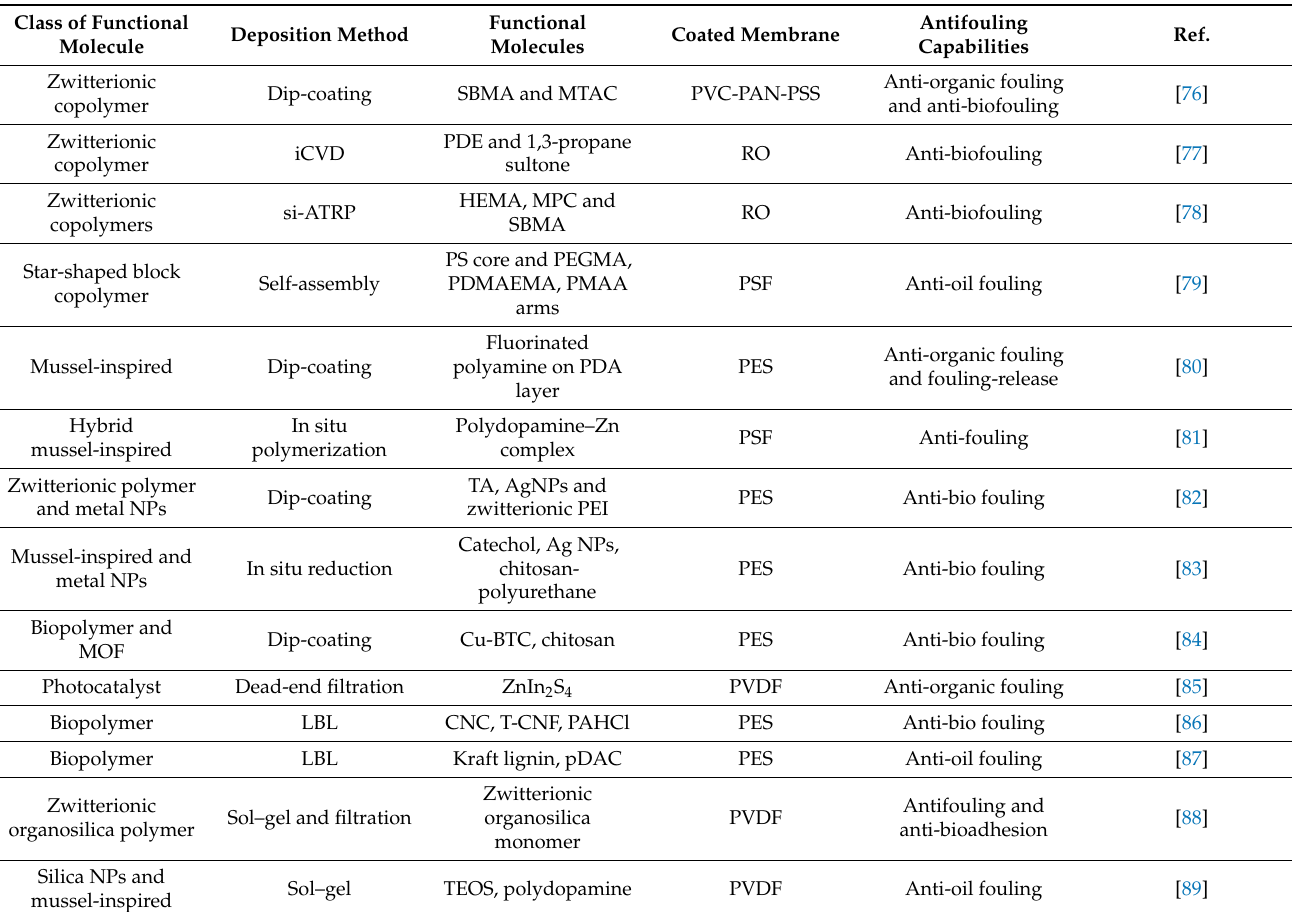
Table 3. Different antifouling coatings for filtration